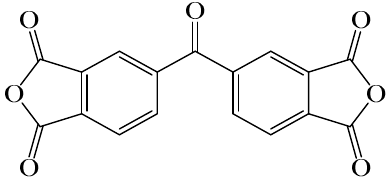
Figure 20. Chemical structure of 3,3 (cid:48) ,4,4 (cid:48) -Benzophenonetetracarboxylicdianhydride (BTDA).